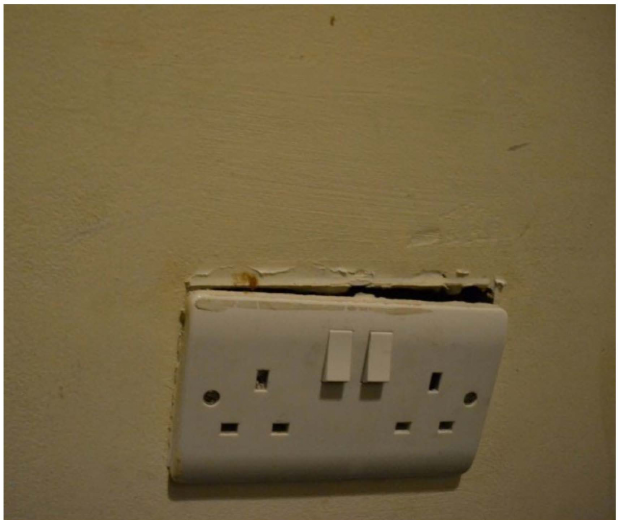
Figure 17. House